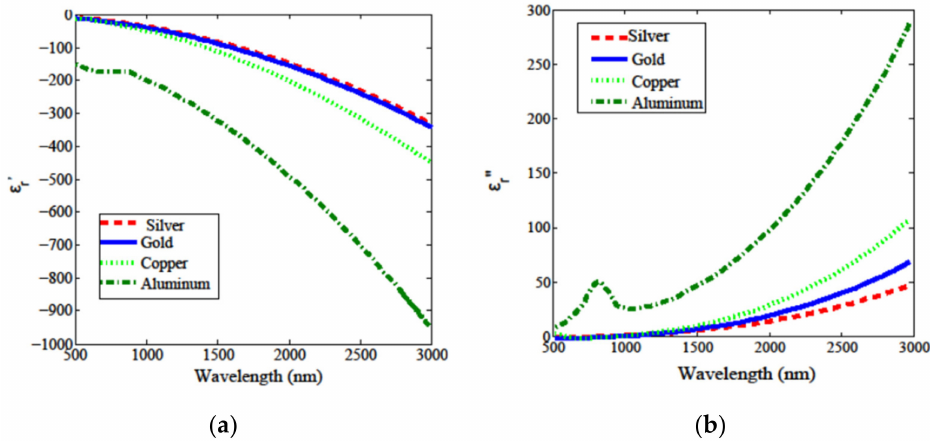
Figure 12. Permittivity of noble metals Au, Ag, Cu and Al: ( a ) real component; ( b ) imaginary component. Reproduced with permission from